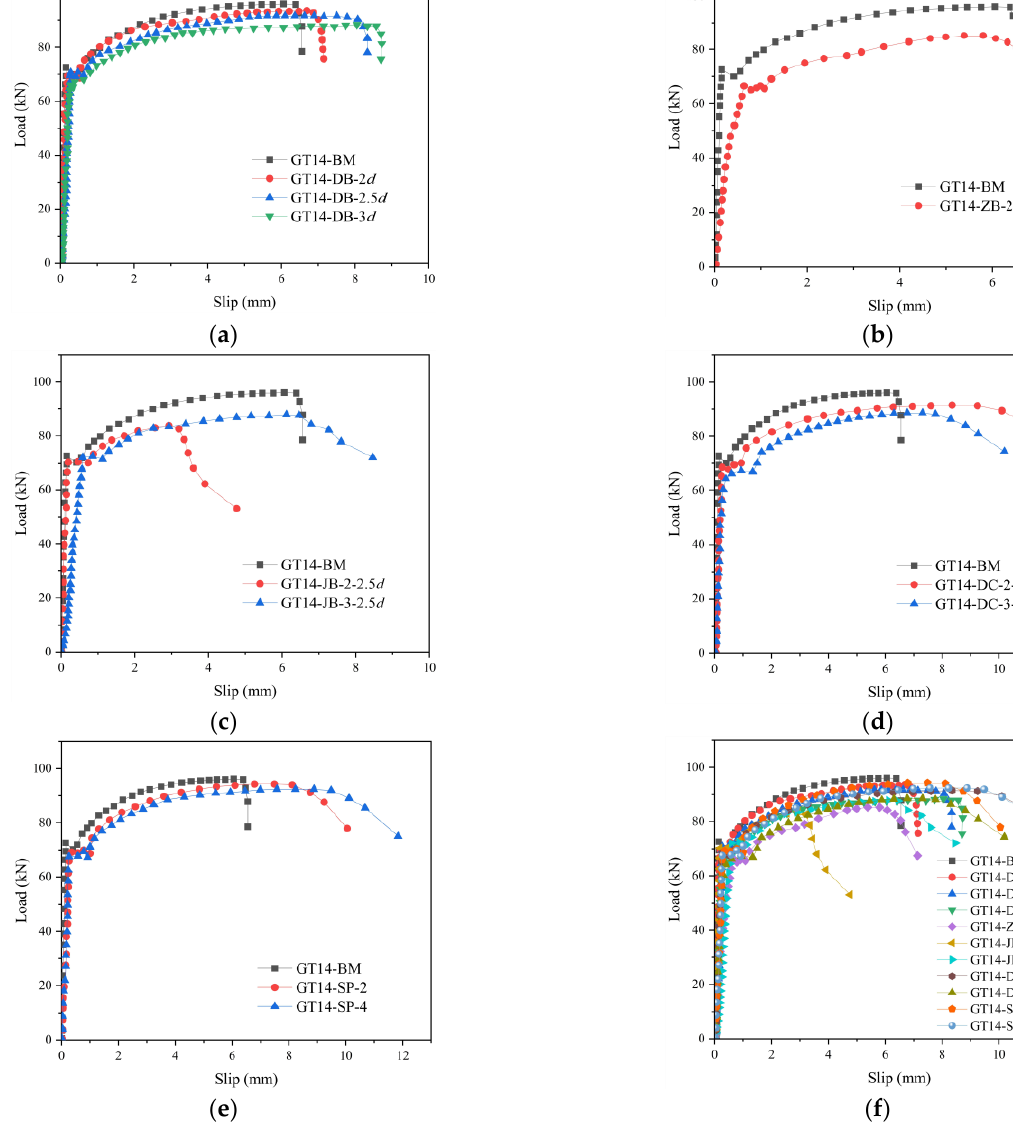
Figure 13. Load – slip curves. ( a ) GT14-BM + GT14-DB. ( b ) GT14-BM + GT14-ZB. ( c ) GT14-BM + Figure 13. Load–slip curves. ( a ) GT14-BM + GT14-DB. ( b ) GT14-BM + GT14-ZB. ( c ) GT14-BM + GT14-JB. GT14-JB. ( d ) GT14-BM + GT14-DC. ( e ) GT14-BM + GT14-SP. ( f ) Comparison between curves. ( d ) GT14-BM + GT14-DC. ( e ) GT14-BM + GT14-SP. ( f ) Comparison between